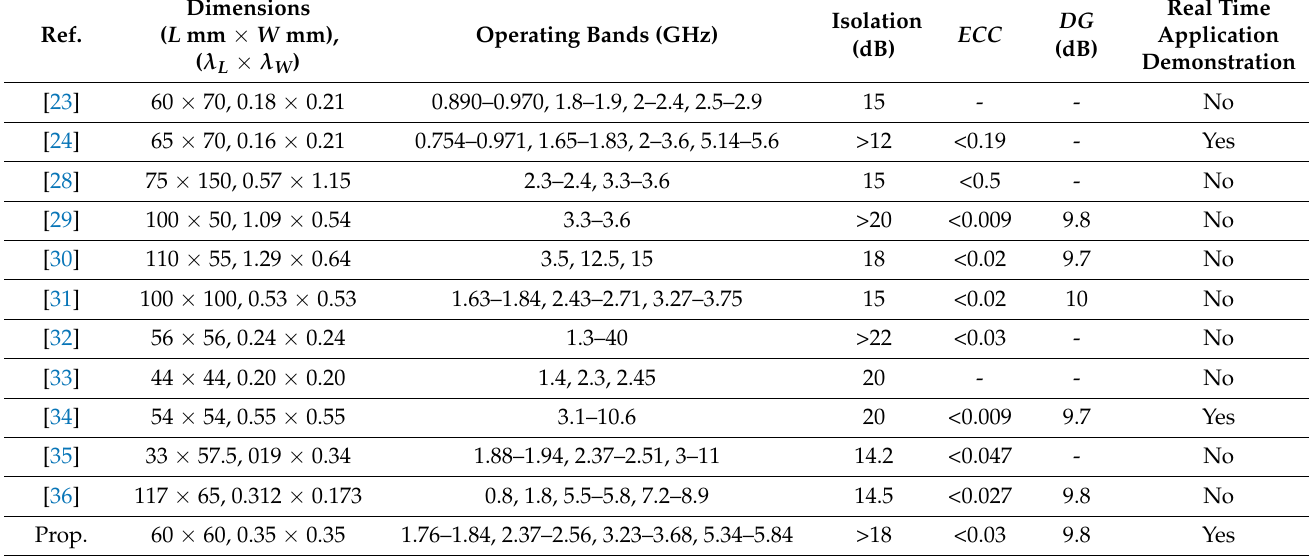
Table 5. Comparison of existing MIMO antennas and the proposed DS MIMO antenna. Dimensions Ref.